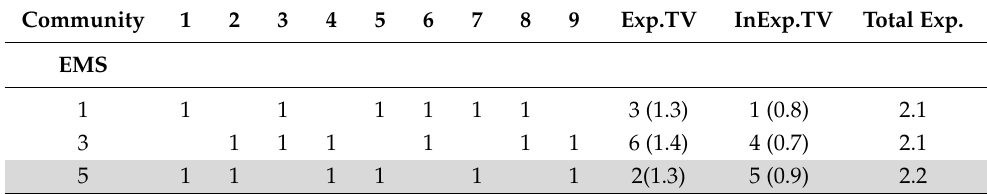
Table 6. TV assignment